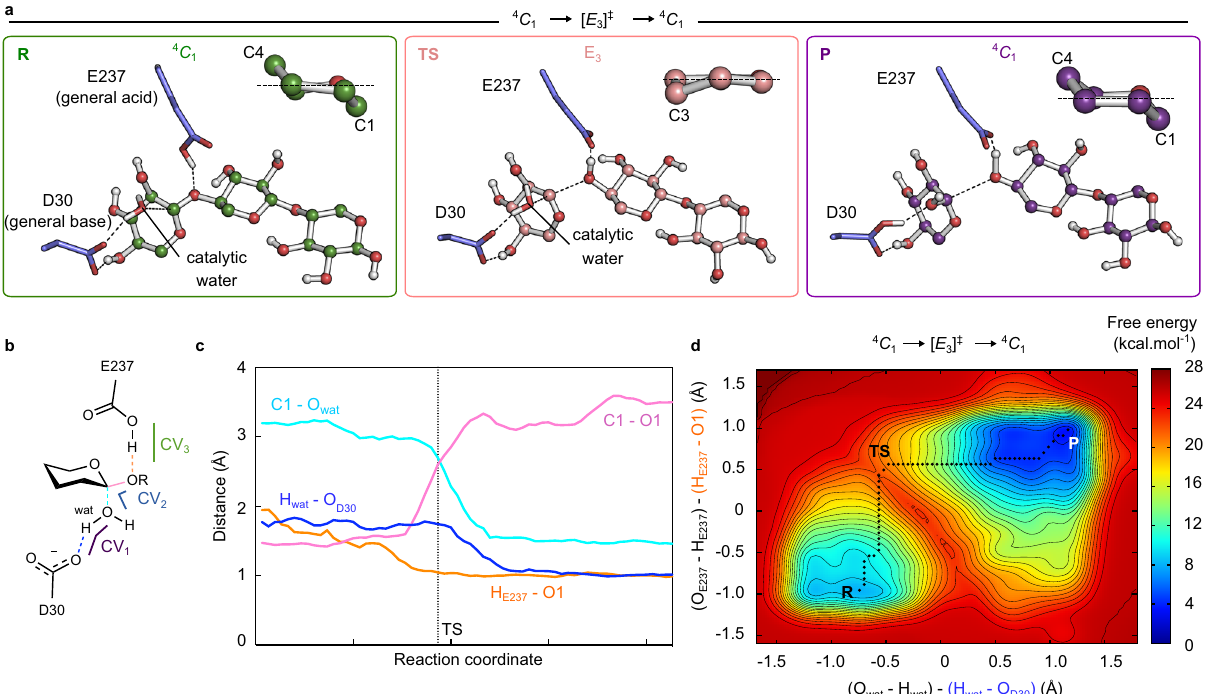
Fig. 8 The 4 C 1 → [ E 3 ] ǂ → 4 C 1 catalytic itinerary. a Representative snapshots of the reactant (R) transition state (TS) and product (P) states of the catalytic itinerary . A zoom of the − 1 sugar conformation is represented at the top right of each state. b Schematic representation of catalytically relevant distances and collective variables (CV 1 , CV 2 , and CV 3 ) (wat = catalytic water). The CV 1 (purple) corresponds to the difference between O wat -H wat and H wat -O Asp30 distances. The CV 2 (blue) was taken as the difference between C1 xylosyl – O4 xylosyl and O wat – C1 xylosyl distances. The CV 3 (green) was taken as the difference between O Glu237 -H Glu237 and H Glu237 -O1 xylosyl distances. c Evolution of these distances represented in b (running averages over fi ve data points) along the reaction pathway. The distance between H E237 – O1 is represented in orange, the distance between H wat – O D30 in blue, C1-O wat in cyan and the glycosidic bond (C1-O1) in pink. d FEL of the catalytic reaction starting from 4 C 1 , projected into CV 1 ((O wat -H wat ) – (H wat -O Asp30 )) and CV 3 ((O Glu237 -H Glu237 ) – (H Glu237 -O1 xylosyl )). The corresponding 3D FEL is shown in Supplementary Fig. 10. The minimum free energy pathway is indicated with a black dashed line on the two-dimensional FEL. Isolines are at intervals of 1 kcal mol − 1 . Source data are provided as a source data fi